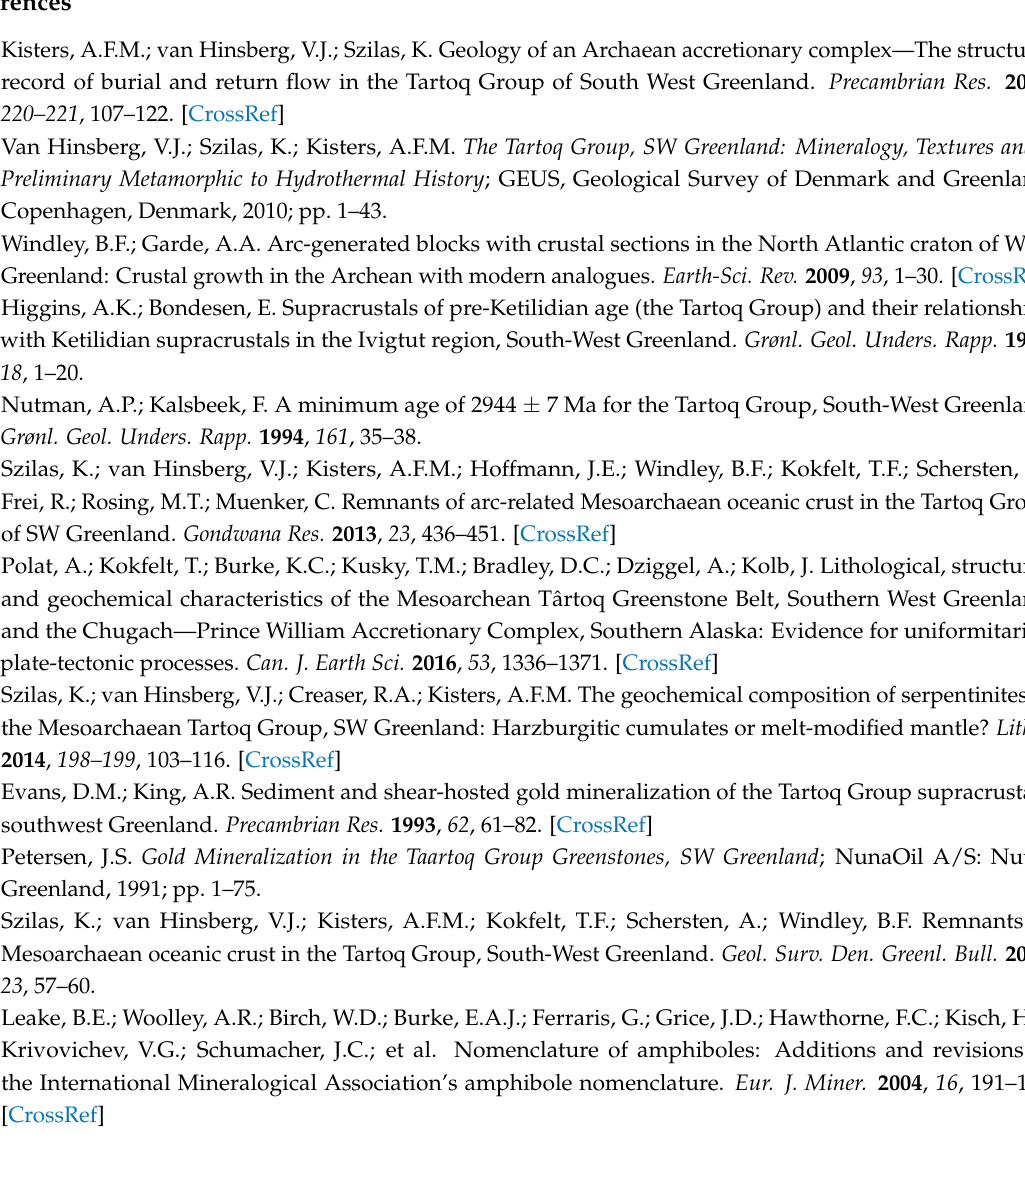
s1, Table S1: Bulk rock compositions for samples used in pseudosection modeling; Table S2: Major element compositions for minerals in the Tartoq greenstone belt; Table S3: Geothermobarometry results; Table S4: Bulk rock compositions for TTG gneisses and the calculated partial melt